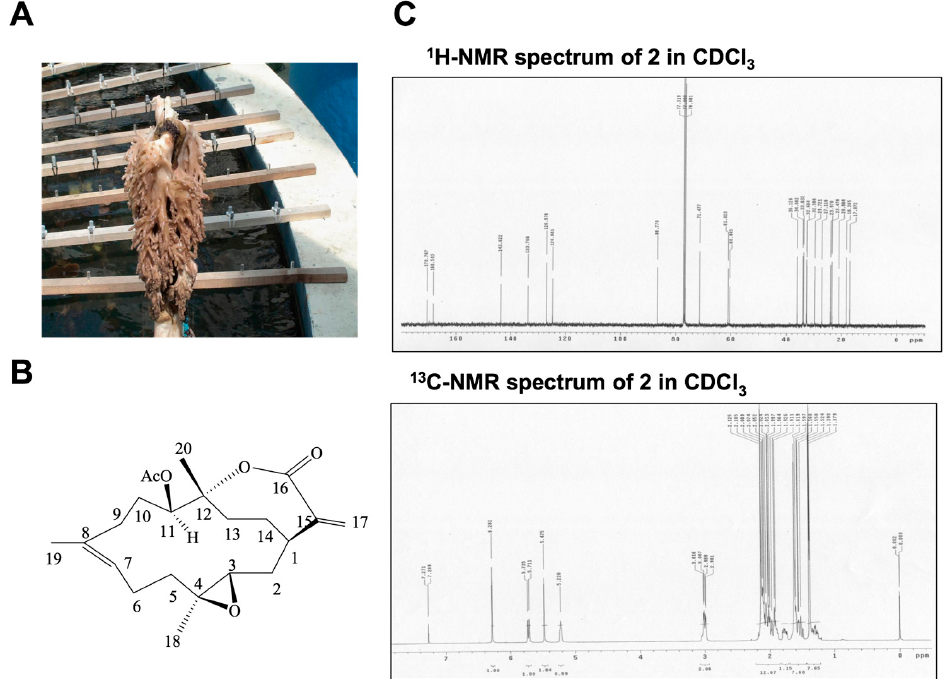
Figure 1. General characteristics of 11- epi -sinulariolide acetate (11- epi -SA). ( A ) Photograph of cultured soft coral Sinularia flexibilis obtained from the National Museum of Marine Biology and Aquarium, Pingtung, Taiwan; ( B ) Chemical structure of 11- epi -SA. The molecular formula and molecular weight of 11- epi -SA are C 22 H 32 O 5 and 376 Da, respectively; ( C ) Typical proton nuclear magnetic resonance ( 1 H-NMR) spectrum of 11- epi -SA in deuterochloroform (CDCl 3 ) at 400 MHz and carbon-13 ( 13 C)-NMR spectrum of 11- epi -SA in CDCl 3 at 100 MHz.